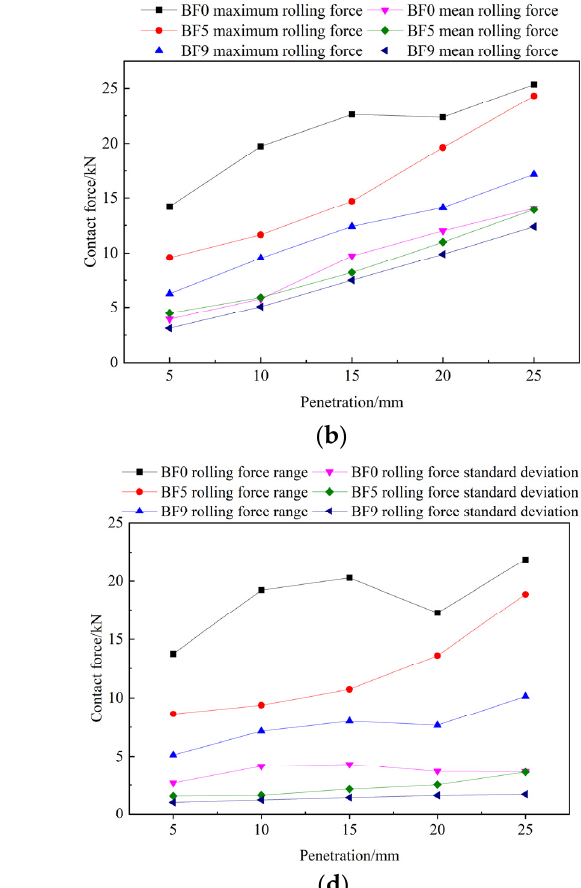
Figure 15. Save contact force data in EXCEL format.